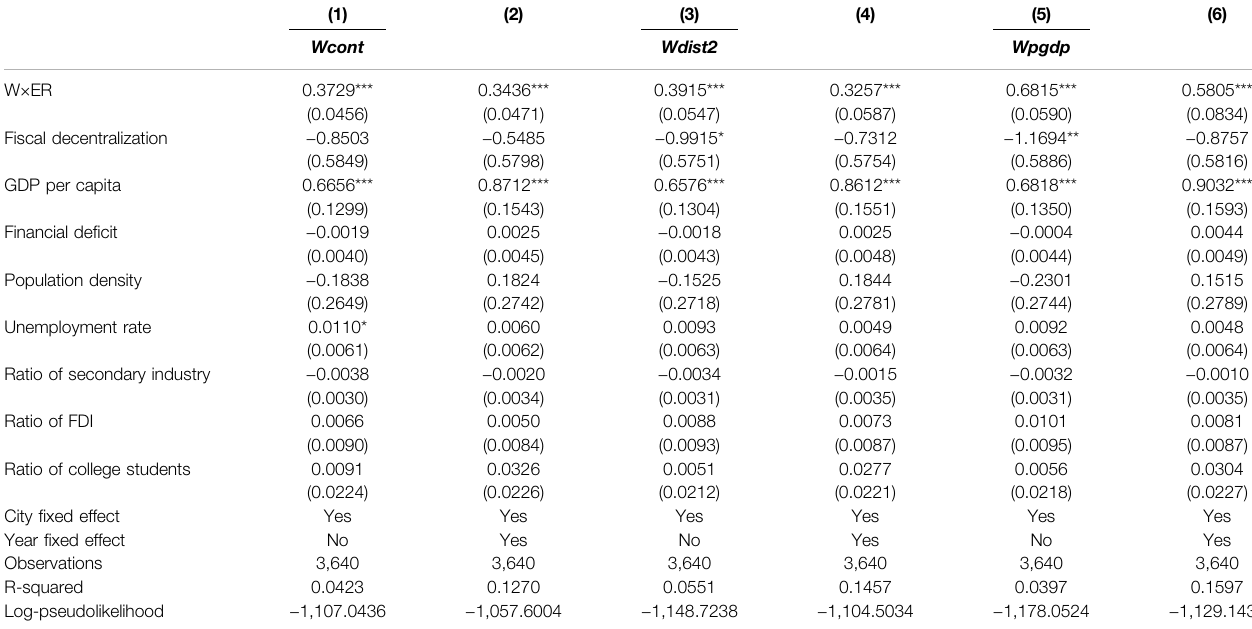
TABLE 4 | Baseline results for three types of spatial weight